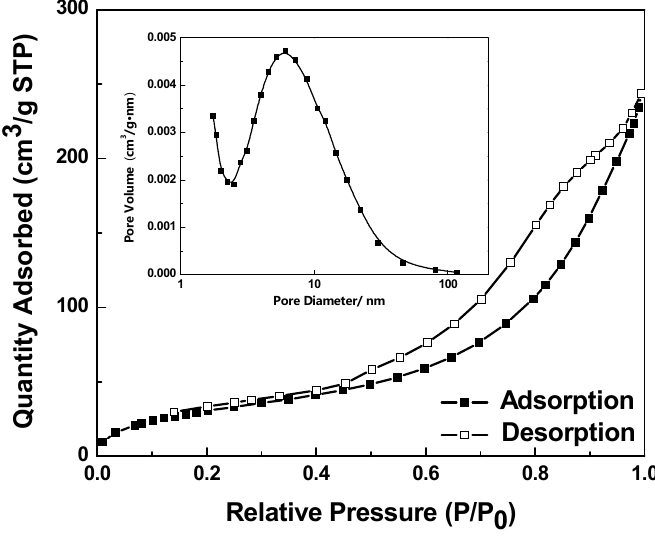
Figure 5. N 2 adsorption and desorption isotherms and pore size distributions (inset) of Fe 3 O 4 /TiO 2 N 2 adsorption and desorption isotherms and pore size distributions (inset) nanocomposite.